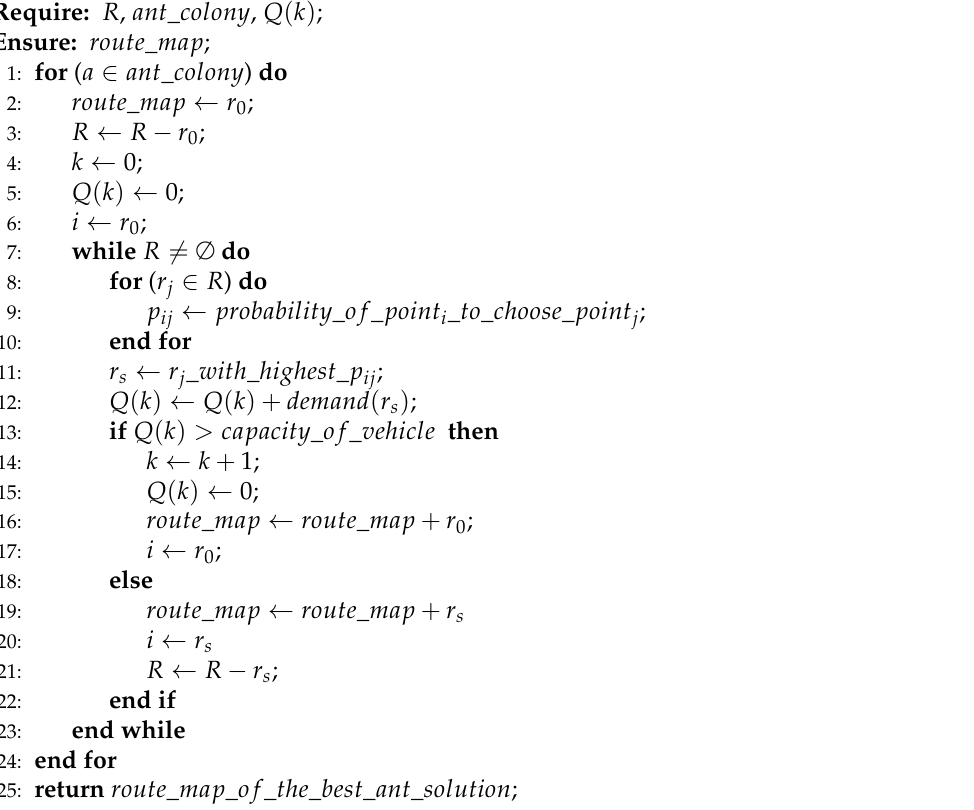
Algorithm 1 Routing and sequencing of the first